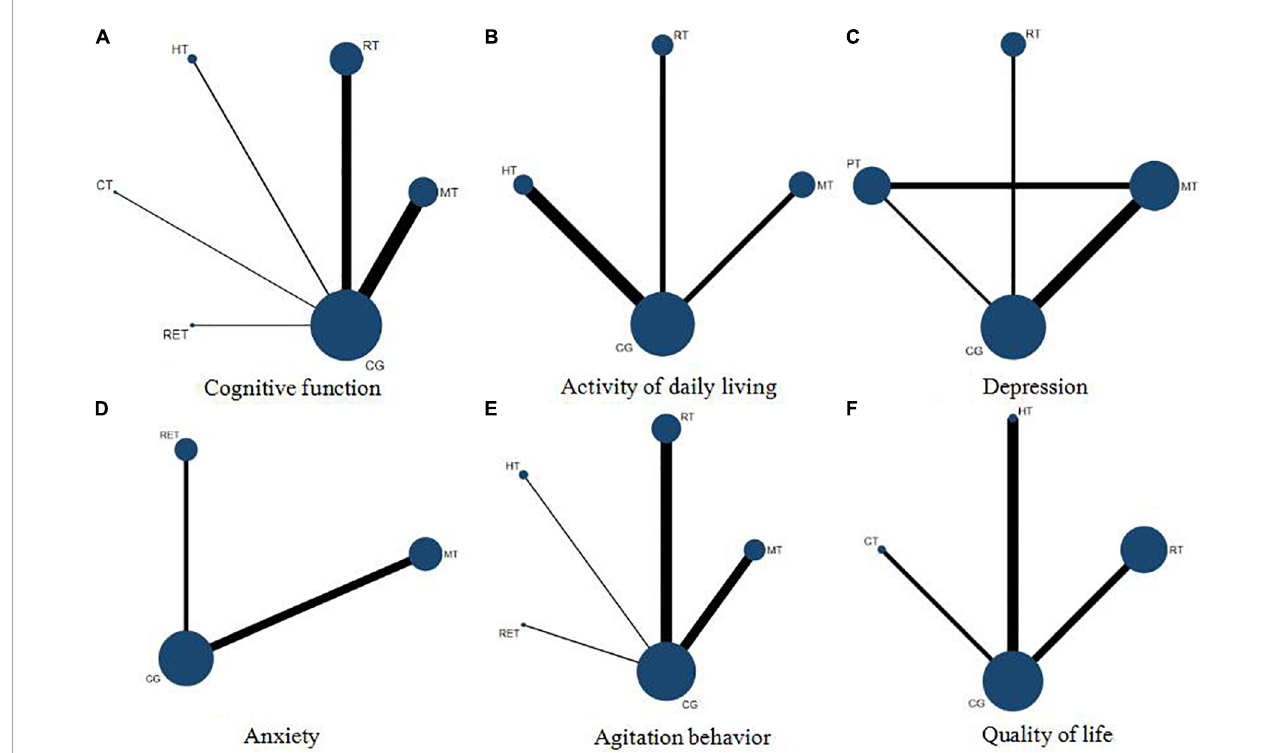
FIGURE2 Network plots of cognitive function (A) , activity of daily living (B) , depression (C) , anxiety (D) , agitation behavior (E) , and quality of life (F) . MT, music therapy; RT, reminiscence therapy; HT, horticultural therapy; CT, calligraphy therapy; RET, reading therapy; PT, painting therapy; CG, control group with usual